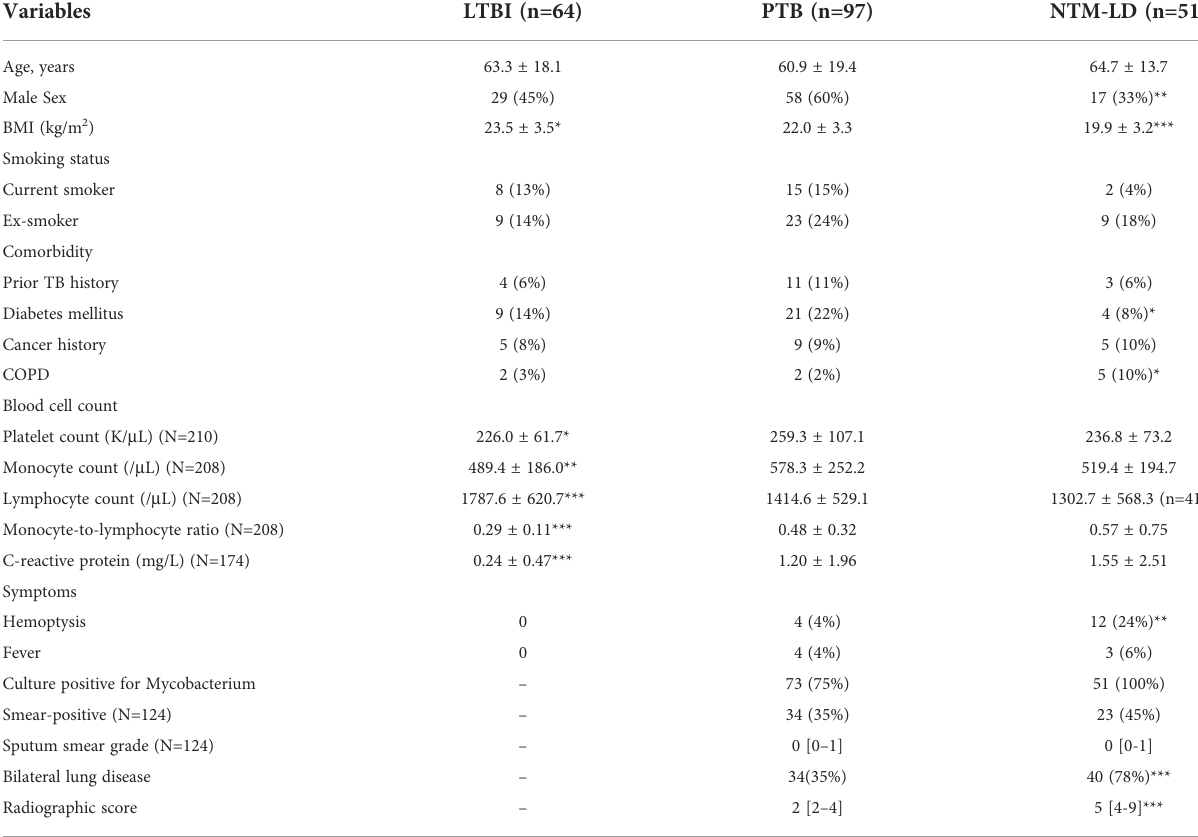
TABLE 1 Demographic and clinical characteristics of patients with latent tuberculosis infection (LTBI), pulmonary tuberculosis (PTB), and nontuberculous mycobacterial lung disease (NTM-LD) (N=212). Variables